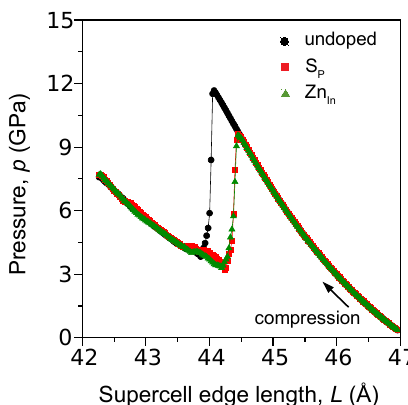
Figure 1. Results of MD simulations showing pressure ( p ) versus supercell edge length ( L ) relation- ship obtained for undoped as well as Zn- and S-doped InP crystal. The sudden drop of the pressure indicates instability and transformation of the initial B3 phase to a high-pressure one. Doping by Zn or S decreases the pressure of the phase transformation.